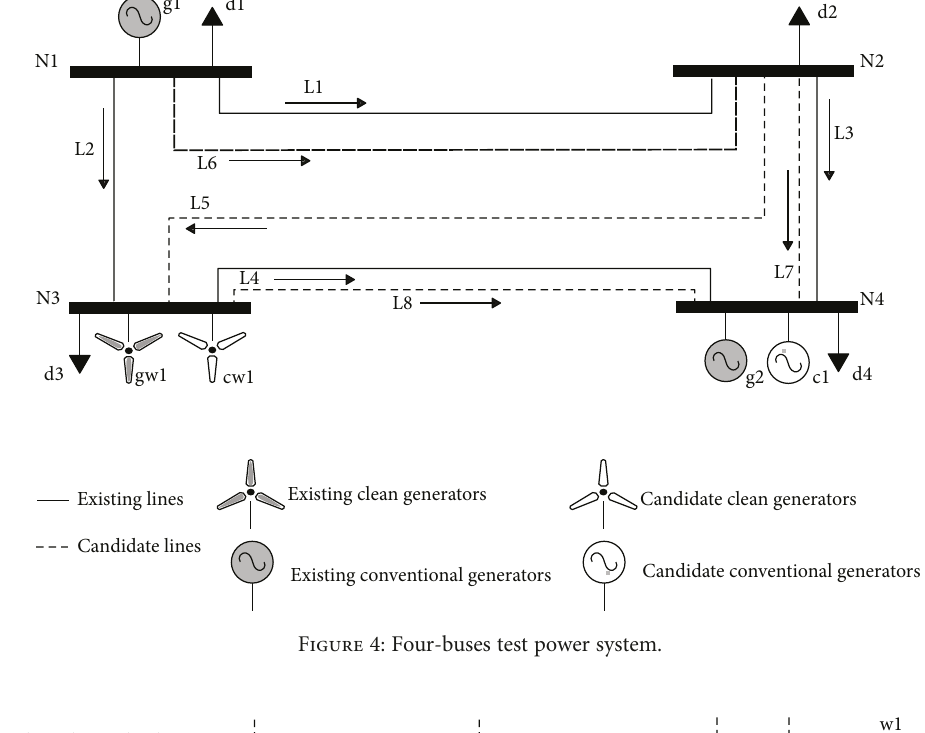
Figure 4: Four-buses test power